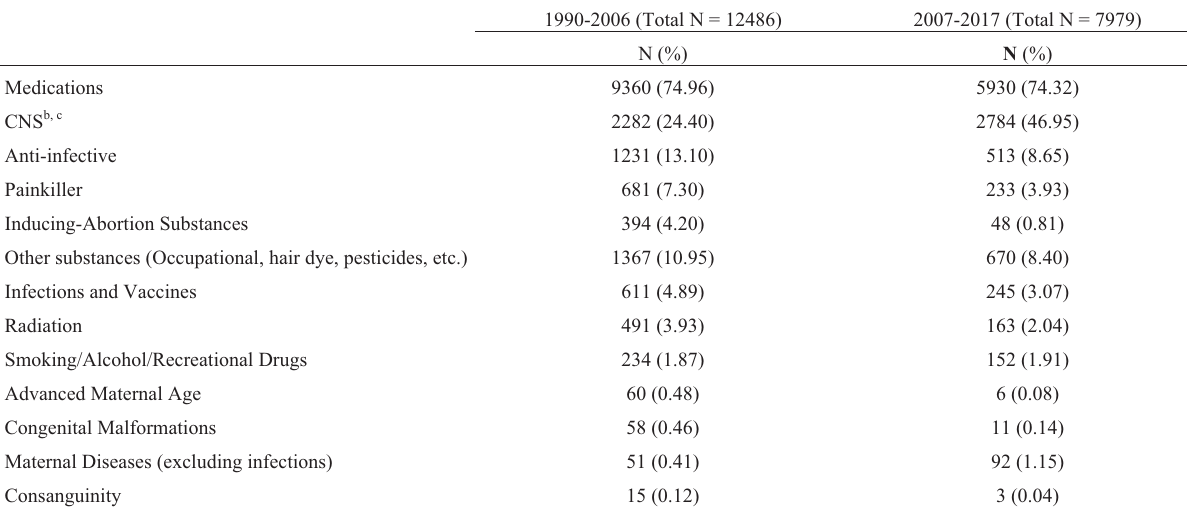
Table 3 - Reasons for Calls (Exposures) a